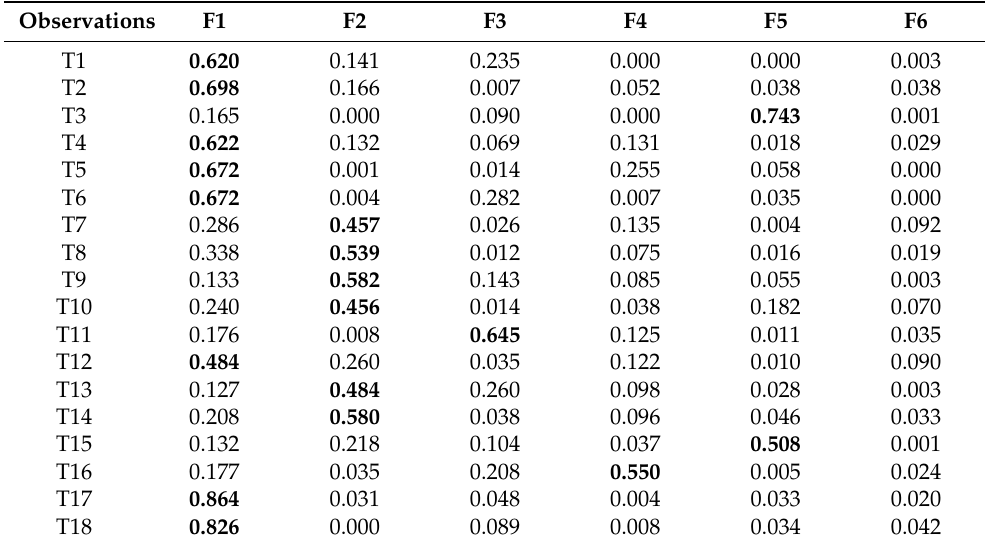
Table 11. Squared cosines of the observations (T1 . . . T18) for TSS , COD , and FM versus PCs (F1 . . . F6).